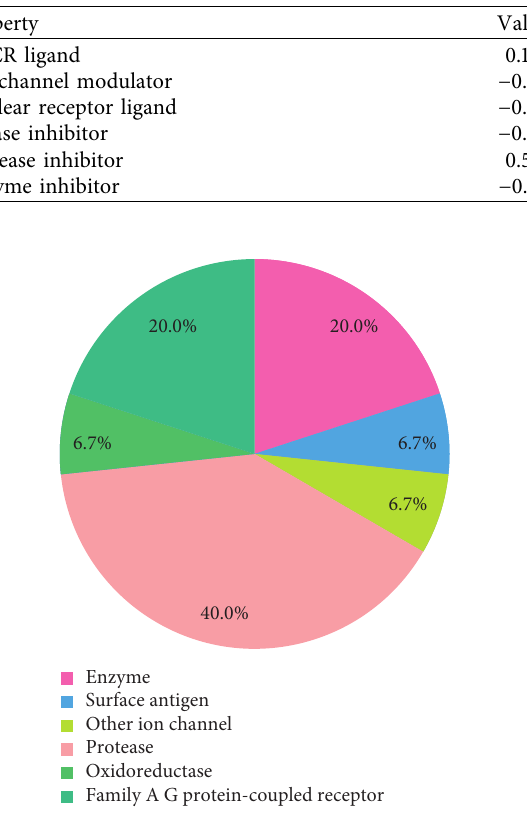
Figure 7: Predicted biological targets of alternaramide marine cyclopentadepsipeptide. Table 7: Absorption properties of the alternaramide marine